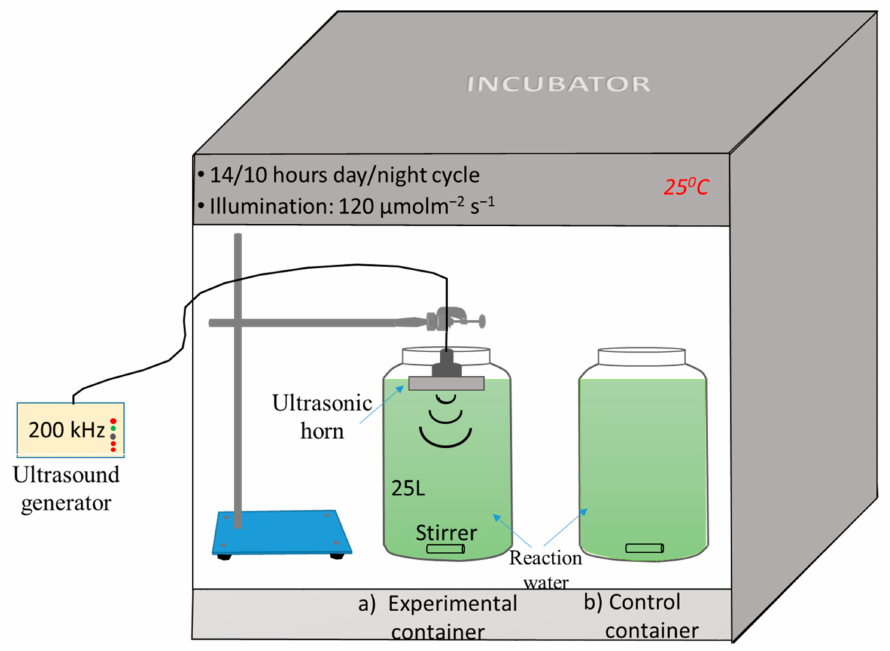
Figure 1. Sketch of the ultrasonic probe and reaction system of the experimental setup housed in an